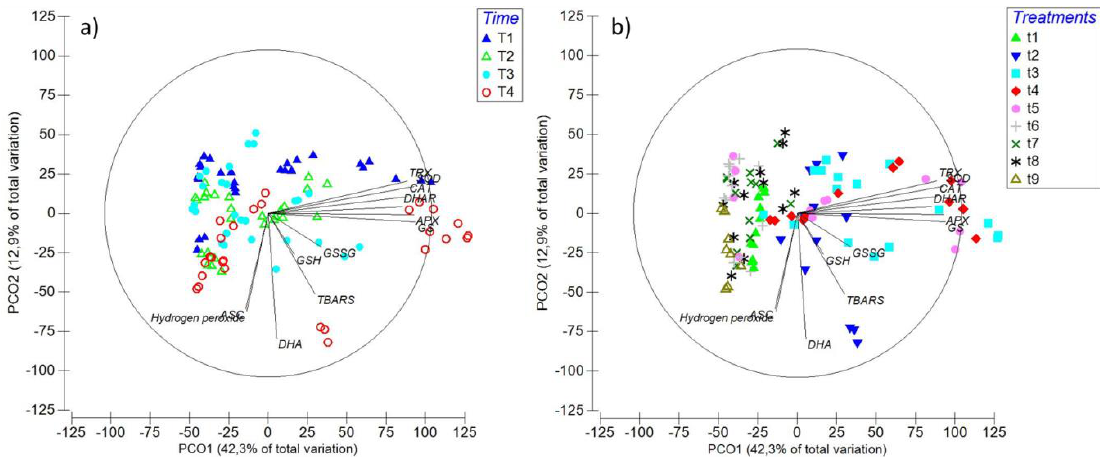
Figure 7. Principal components ordination (PCO) analysis diagrams in relation with time ( a ): T1: 6 h, T2: 24 h, T3: 48 h, and T4: 6 d; and treatments ( b ): t1: Control only with seawater, t2: Solely copper exposure as 10 µM of CuSO 4 (Cu), t3: copper + 5 µM MAPK ERK inhibitor PD98059 (Cu + ERKi), t4: Copper + 5 µM MAPK JNK inhibitor SP600125 (Cu + JNKi), t5: Copper + MAPK p38 inhibitor